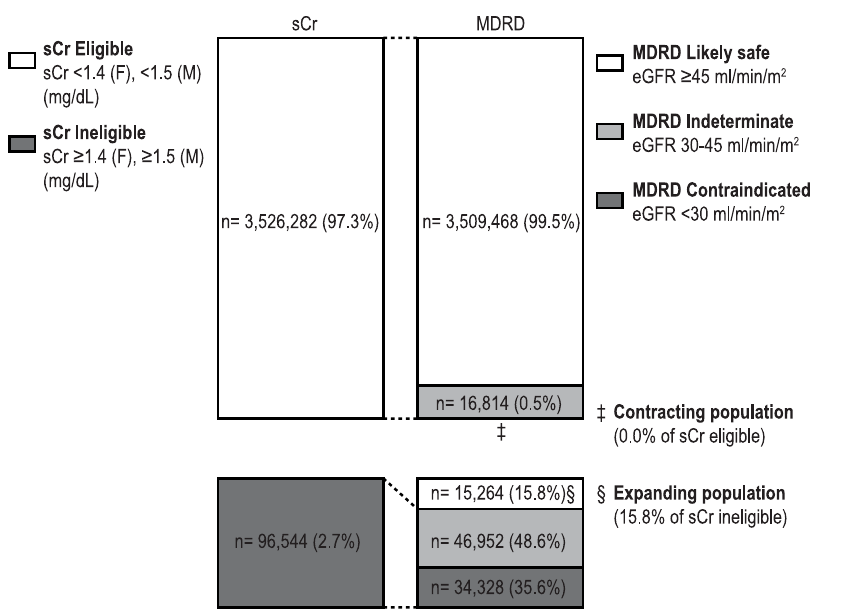
Fig 2. Expanding effects of changing from sCr-based to eGFR-based (MDRD) metformin prescription. Each number representsnationalestimates of each populations. sCr, serum creatinine; eGFR, estimated glomerular filtration rate; F, female; M,